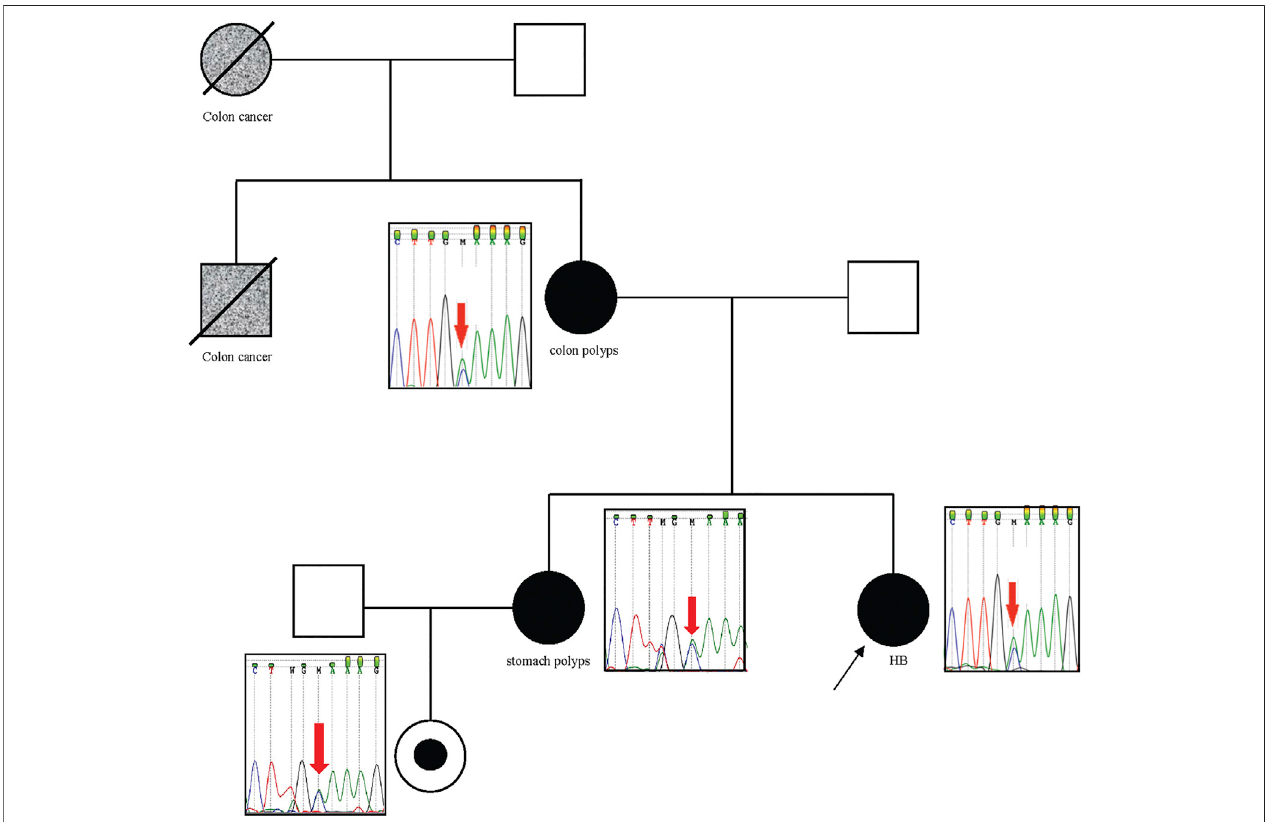
FIGURE 3 | APC pathogenic variant segregates with the cancer phenotype in the family of patient P27. The patient P27 is indicated with the black arrow. P27, her mother, sister, and niece are carriers of the pathogenic p. Cys1249* variant in the APC gene, which was identi fi ed by exome sequencing in the patient, and validated by Sangersequencingintheirindicatedrelatives.Hermotherandsisterhadcolonpolypsandstomachpolyps,respectively.Thematernalgrandmotherandunclehadcolon cancer (both are dead).